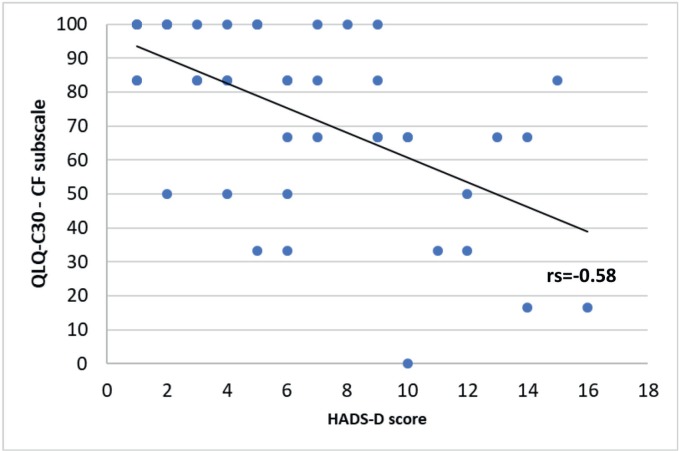
Correlation between HADS-D and the cognitive functioning (CF) subscale of EORTC QLQ-C30.